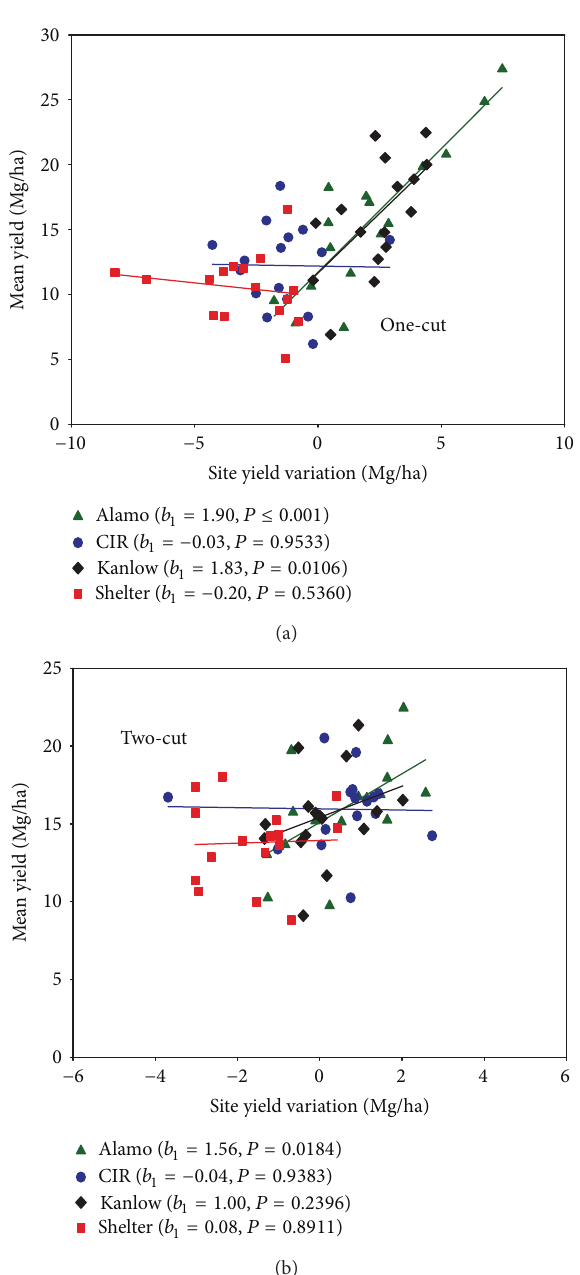
Figure 2: Regression of each switchgrass cultivar’s mean yield for each location and year against its site yield variation for (a) lower- input, one-cut or (b) higher-input, two-cut systems. A cultivar’s site yield variation was calculated as its mean yield at a location minus the location’s grand mean yield